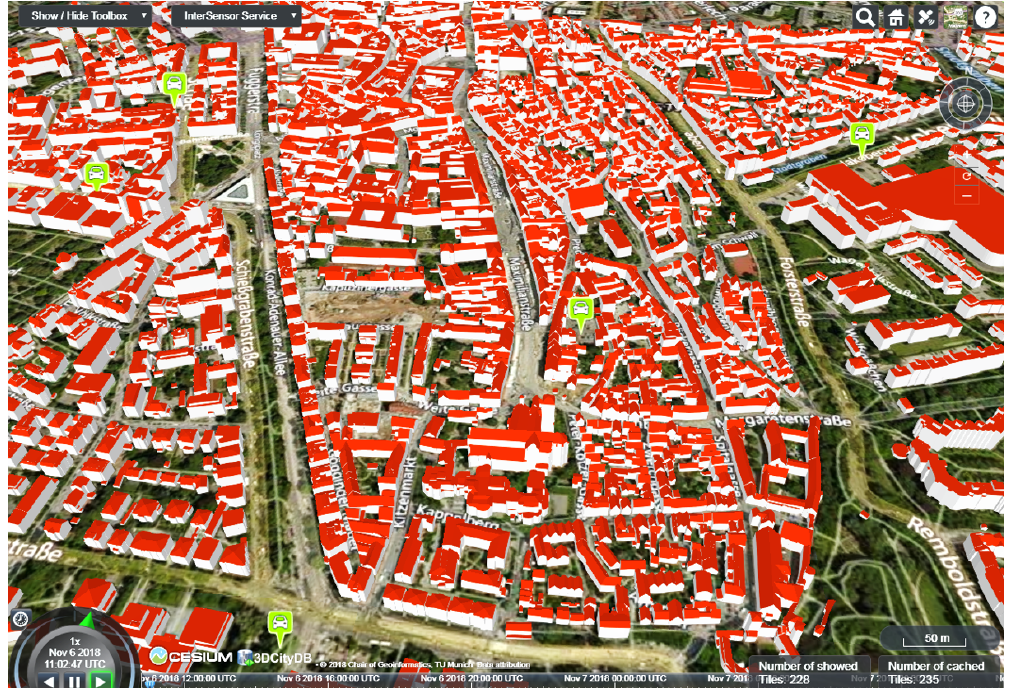
Figure 11. Joint visualization of available rental car information being retrieved by the InterSensor Service along with CityGML-based 3D building objects in the city of Augsburg in Germany. Screenshot taken from 3DCityDB-Web-Map application